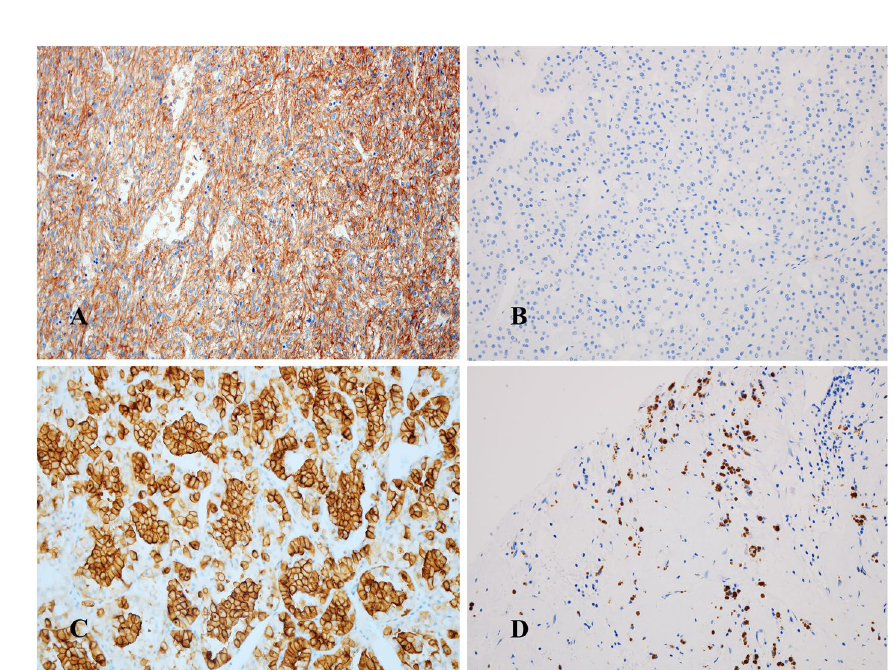
Fig. 1 Immunohistochemical staining for B7‑H3, PD‑L1, and CTLA‑4. B7‑H3 positive staining ( A ); B7‑H3 negative staining ( B ); PD‑L1 positive staining ( C ); CTLA‑4 positive staining ( D